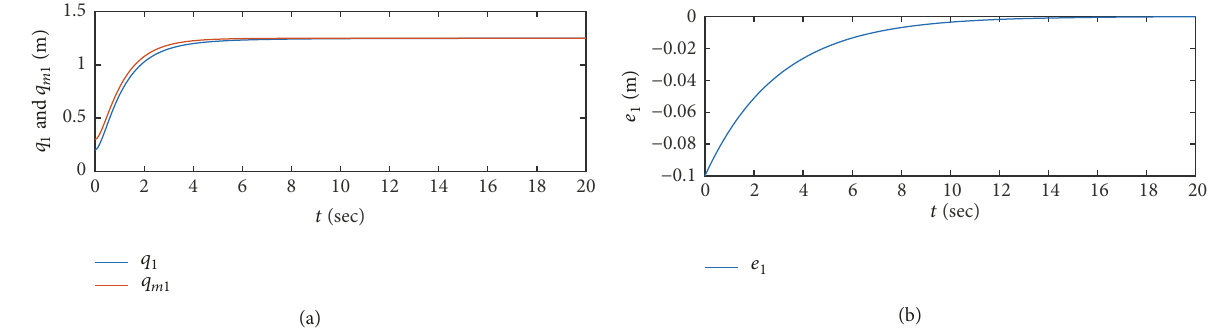
Figure 1: (a) The output of tracking of joint 1. (b) The output of tracking error of joint